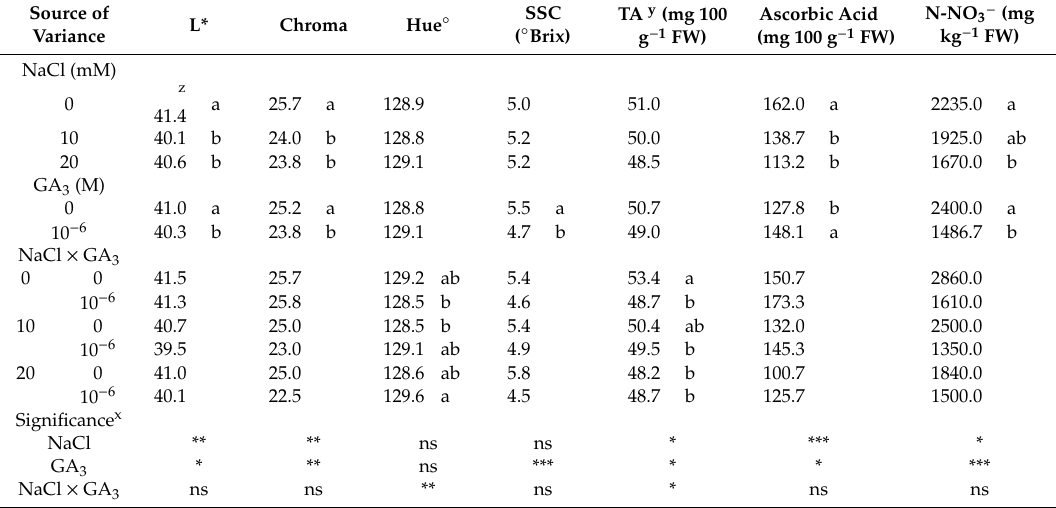
Table 8. Leaf color and chemical characteristics of rocket plants grown in nutrient solutions containing di ff erent levels of NaCl and GA 3